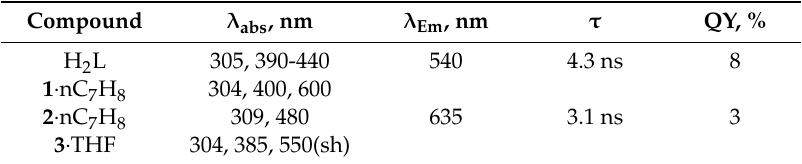
Figure 13. Normalized excitation (left) and emission (right) spectra of H 2 L (black) and 2 · nC 7 H 8 (blue). Table 2. Wavelengths of the absorption ( λ abs ) and emission ( λ Em ) band maxima, excited states lifetimes and absolute quantum yields for H 2 L, 1 – 3 in the solid state at room